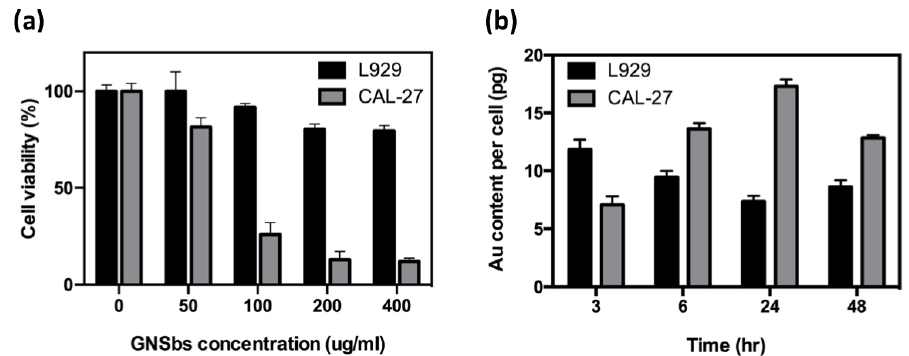
Figure 3. ( a ) Effect of GNSbs on L929 and CAL-27 cell viability after 24 h of treatment. L929 and CAL-27 were treated with various concentrations of GNSbs (0, 50, 100, 200, and 400 µ g/mL) for 24 h. ( b ) Cellular uptake analysis by ICP-MS. Cells were exposed to GNSbs at the concentration of 50 µ g/mL for 0, 3, 6, 24, and 48 h. Intracellular gold content was analyzed in both CAL-27 and L929 cells. Data were reported as gold content per